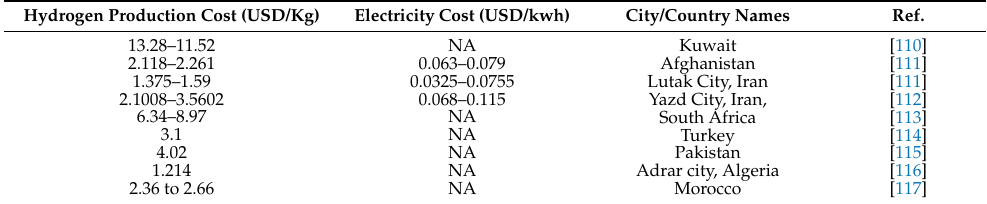
Table 5. Hydrogen production cost and electricity cost-based wind energy